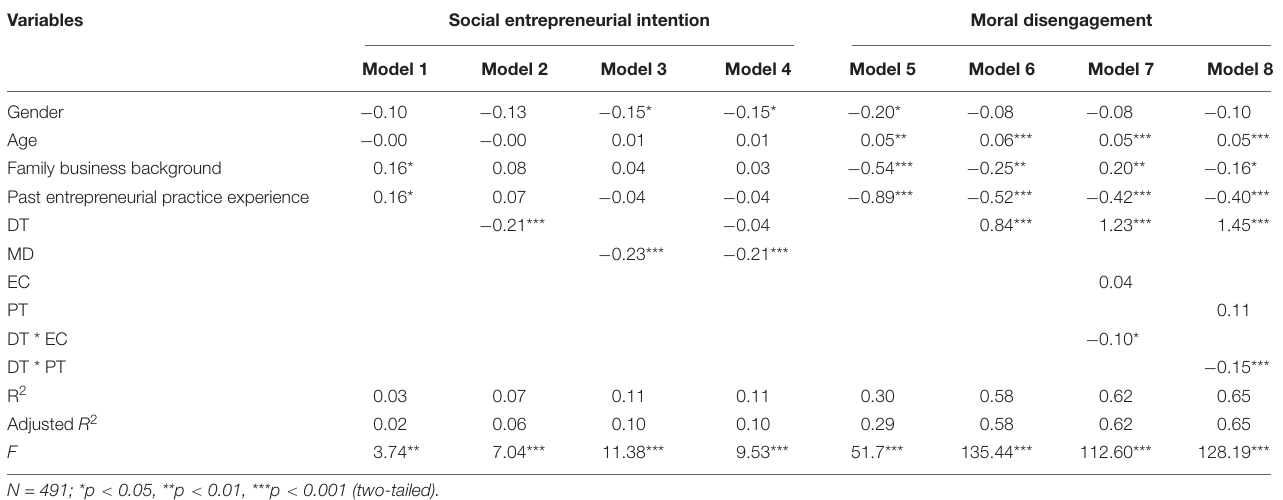
TABLE 2 | Results of multiple regression analysis in Study 1.